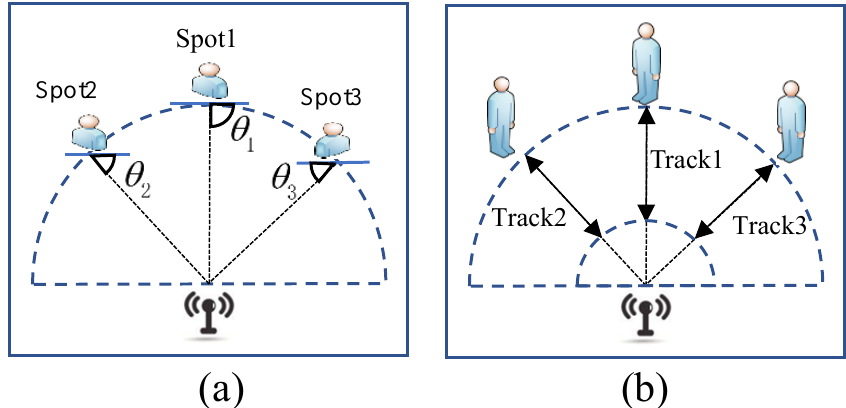
Figure 8. Experimental scenarios for static and moving targets. ( a ) Spot settings in static scenarios, and ( b ) track settings in moving